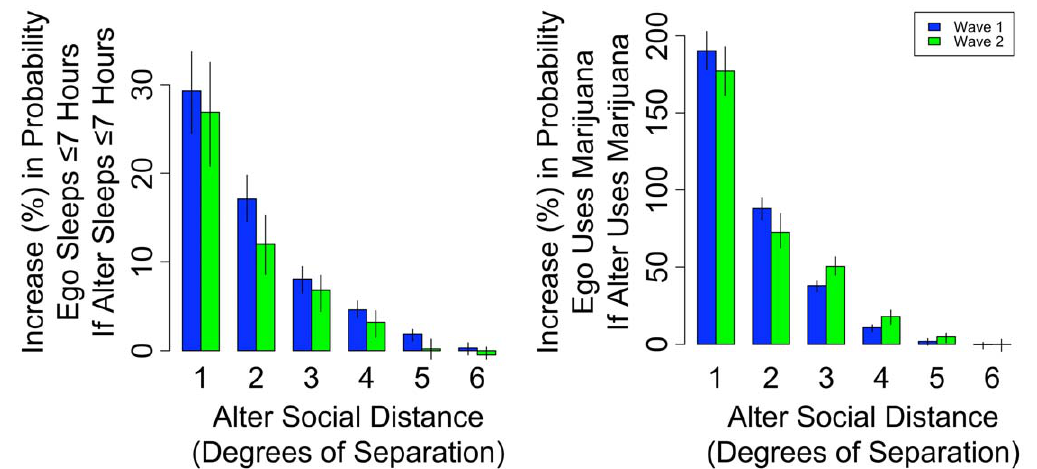
Figure 2. Spread of sleep and drug use. Figure 2 shows that the association between ego and alter sleep is significant up to four degrees of separation in both Wave I and Wave II. The left panel shows the percentage increase in the likelihood a person sleeps # 7 hours if a friend at a certain social distance sleeps # 7 hours. The right panel shows the percentage increase in the likelihood a person uses marijuana if a friend at a certain social distance uses marijuana. The relationship is strongest between individuals who are directly connected, but it remains significantly greater than zero at social distances up to 4 degrees of separation in both Wave I and Wave II. Thus, a person’s sleep and drug use behavior is associated with the same behavior of other people up to 4 degrees removed from them in the network. Error bars are derived by comparing the conditional probability of the behavior in the observed network with an identical network in which topology and incidence of the behavior is preserved but the assignment of the behavior is randomly distributed [19,55 2008]. Alter social distance (degrees of separation) refers to closest social distance between the alter and ego